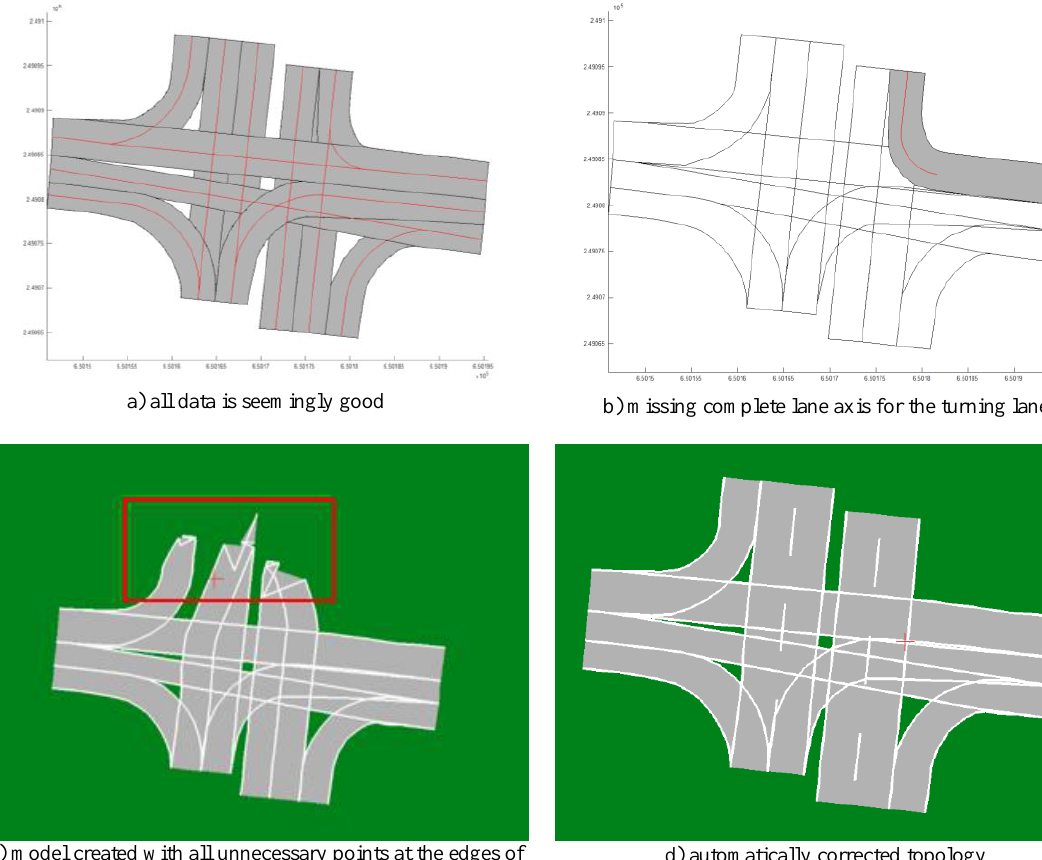
Figure 5. Automatic topology check and